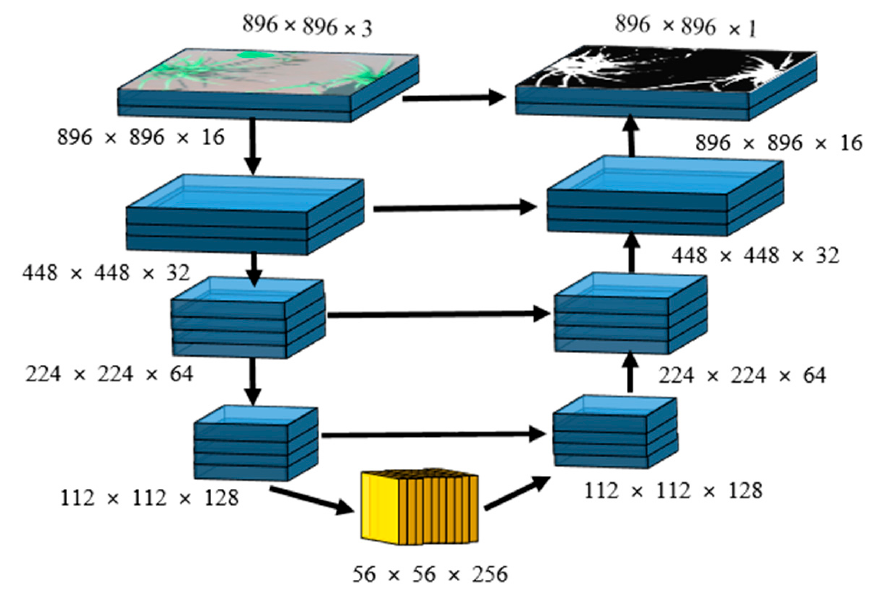
Figure 3. A single encoder-decoder network, which is used in the cascaded form in Figure